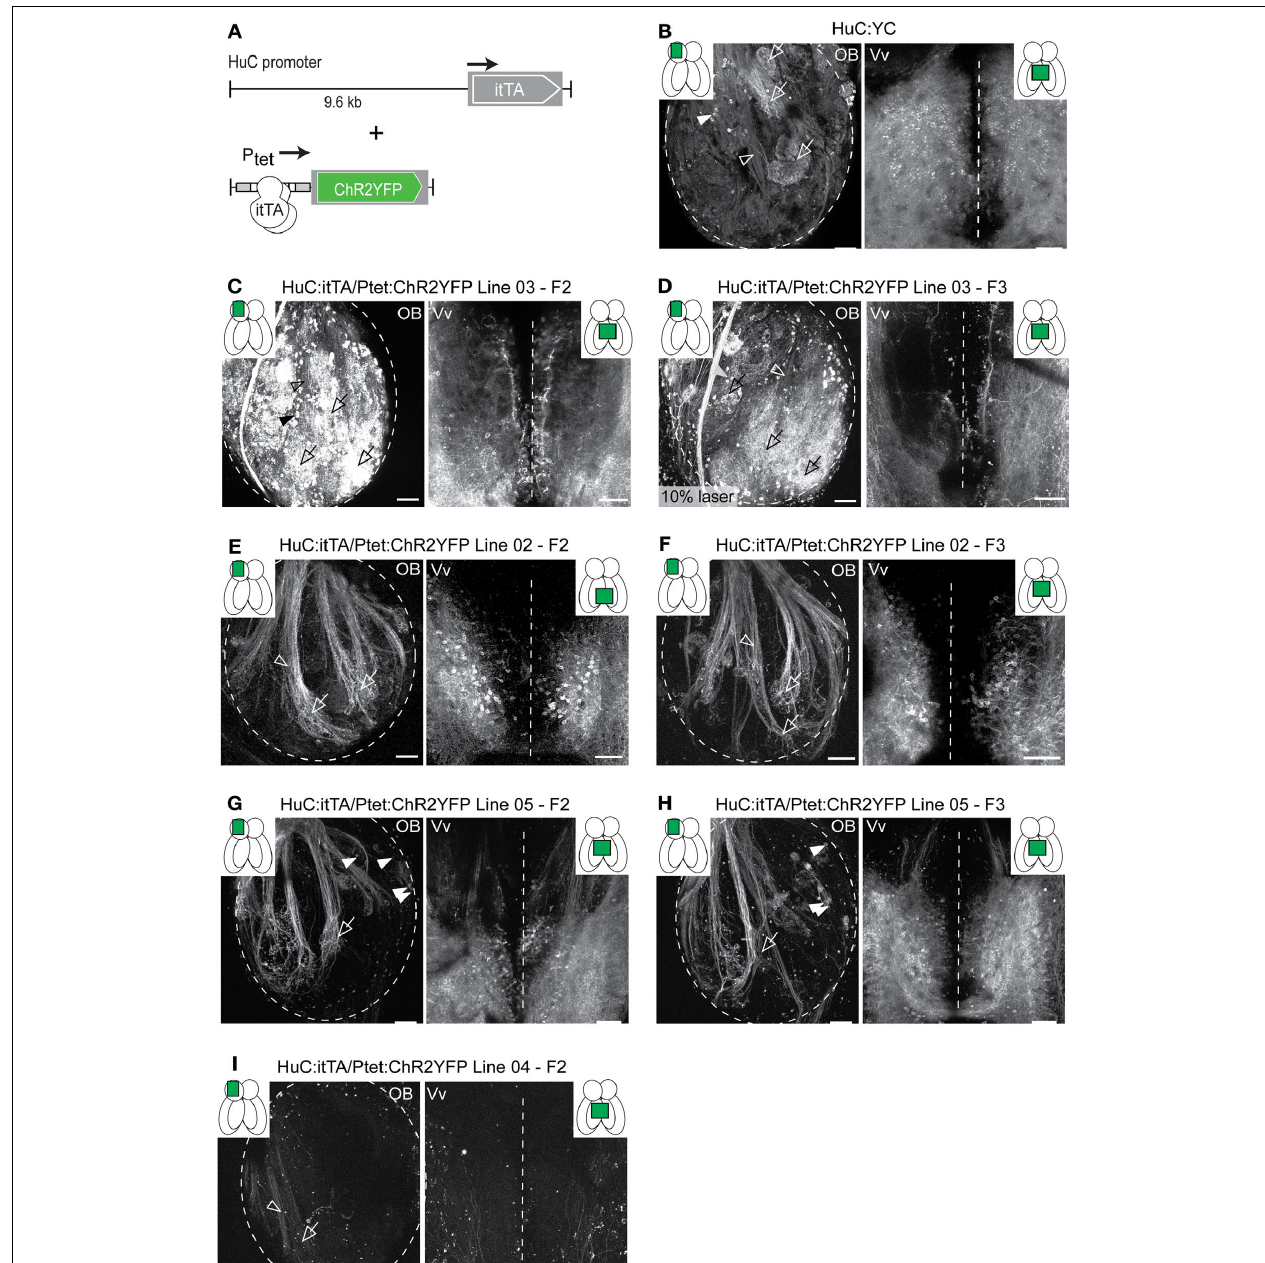
settings to compare brightness. Expression patterns vary between founder lines but are stable between generations. (C,D) Offspring of HuC:itTA/Ptet: ChR2YFP Line 03 strongly express in sensory afferents (open arrowheads), glomeruli (open arrows), mitral cells (fi lled arrowheads) and Vv neurons. Expression in the OB was similar to HuC:YC transgenics (B) . Laser power in (D) was 10 % of that used for other images. (E,F) Offspring of